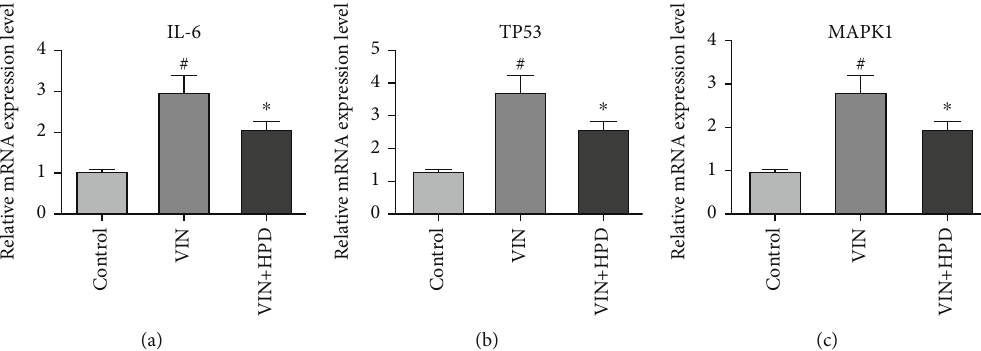
Figure 8: Validation of hub genes. qRT-PCR analysis for di ff erences in mRNA expressions of IL-6 (a), TP53 (b), and MAPK1 (c) in the di ff erent groups. Results were expressed as mean ± SD ( n = 3 ). # P < 0 : 05 , the VIN group compared with the control group; ∗ P < 0 : 05 , the VIN+HPD group compared with the VIN-treated